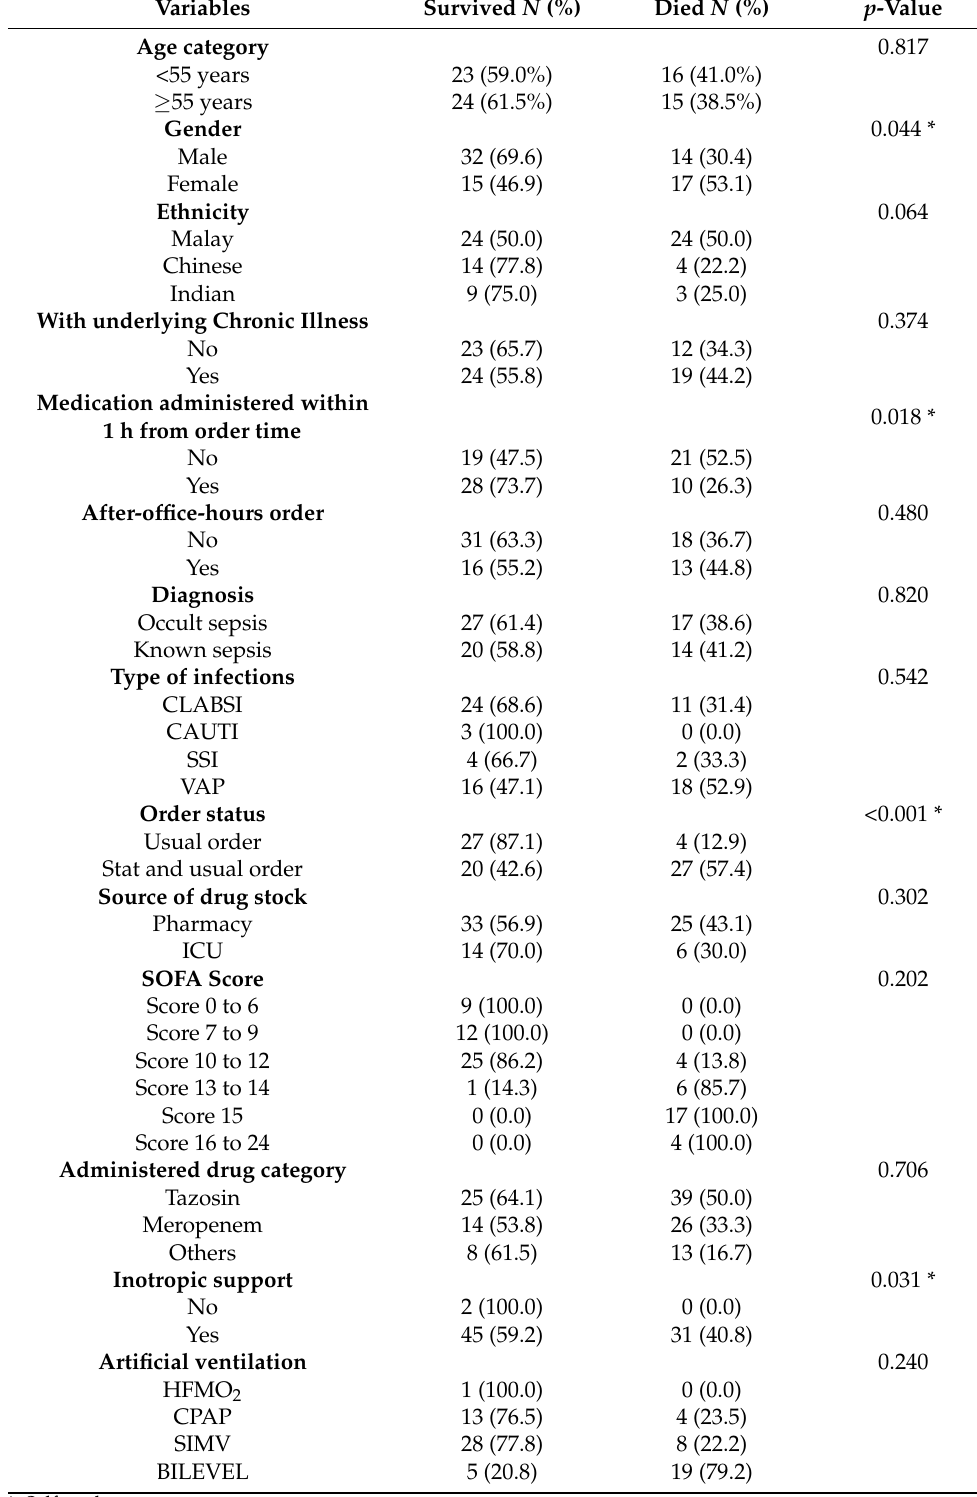
Table 2. Univariate analysis performed to evaluate mortality after 48